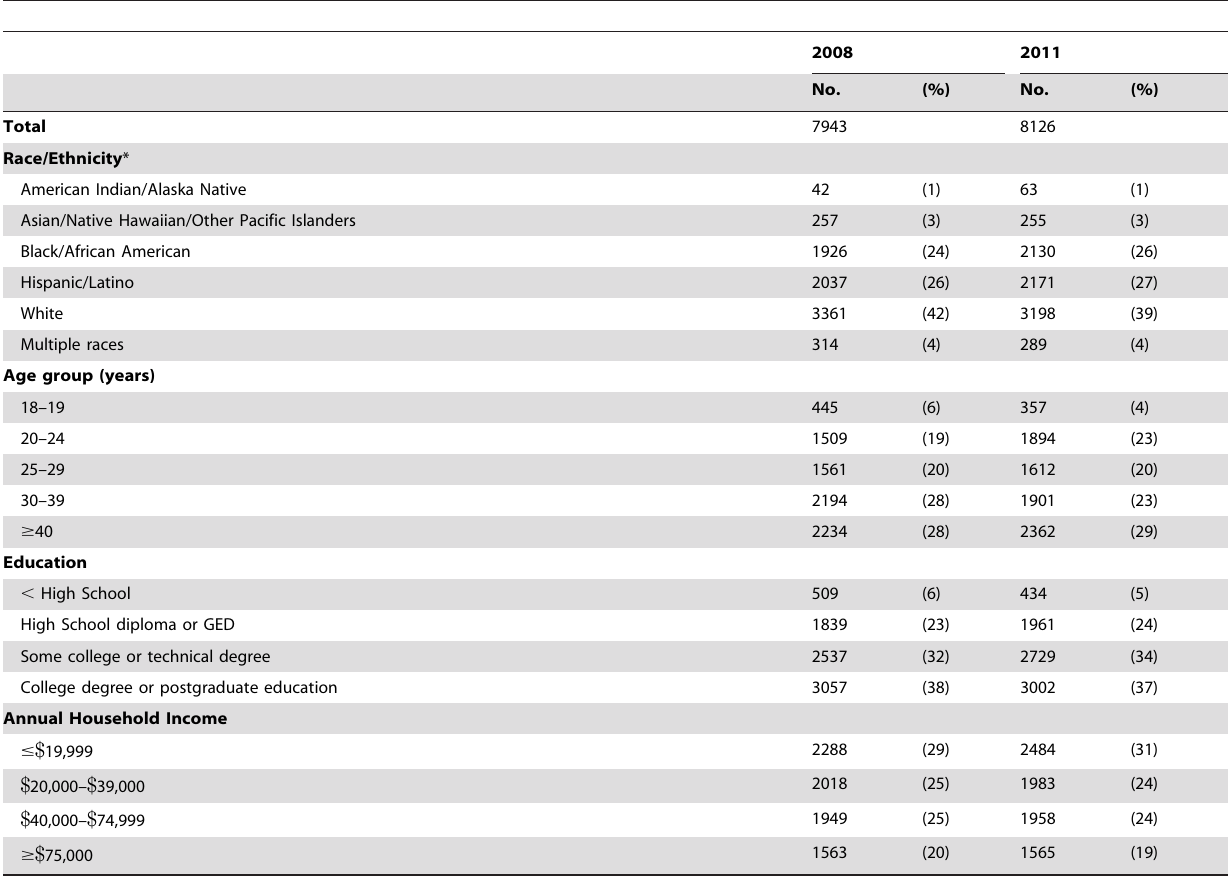
Table 1. Sample characteristics by year among men who have sex with men — National HIV Behavioral Surveillance System, 20 U.S. cities, 2008 and